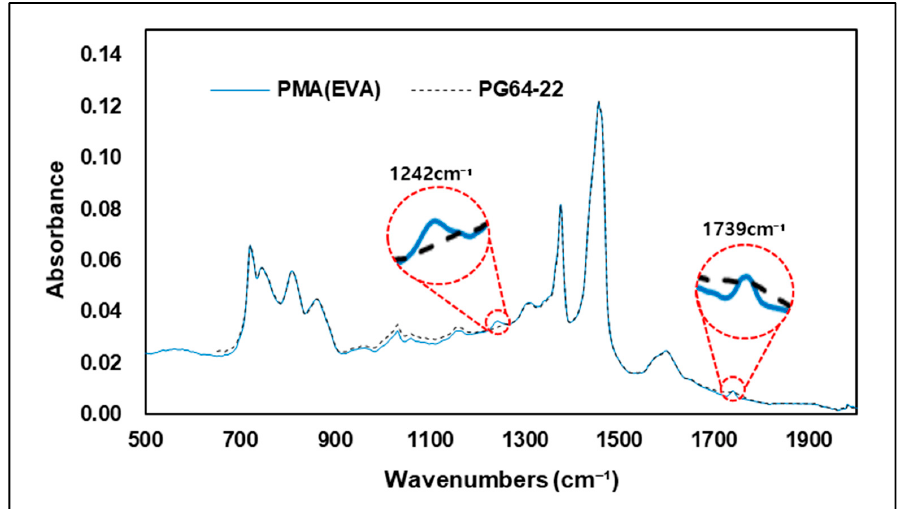
Figure 13. FTIR spectrum of 500–2000 cm − ¹ area.